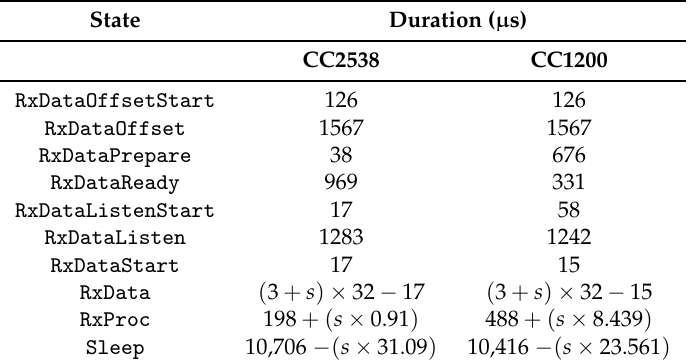
Table 13. State durations in the RxData time slot with a total length of 15ms and s being the packet size in bytes.